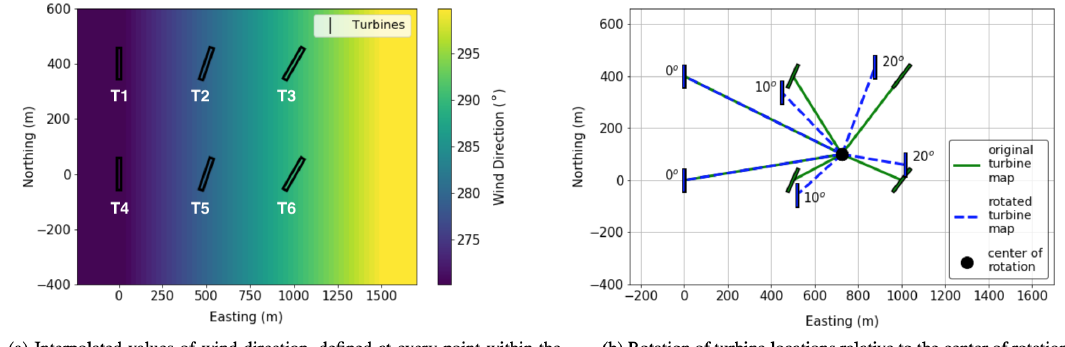
Figure 5. A depiction of the initial processes before the calculation of wakes. Panel (a) shows the result of wind direction interpolation, and panel (b) shows the process used to define the location of the rotated turbine map. The turbines will be referred to individually as T1, T2, T3, T4, T5, and T6, as defined in panel (a)